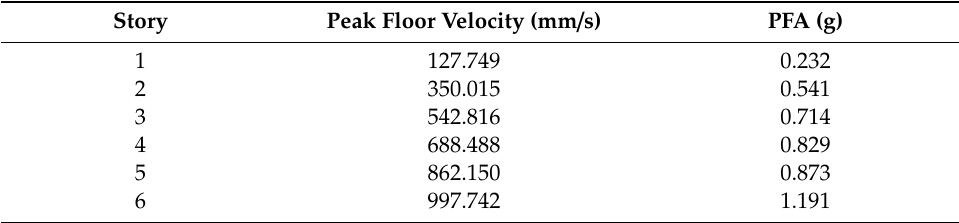
Table 3. EDPs required for the prediction of seismic damage